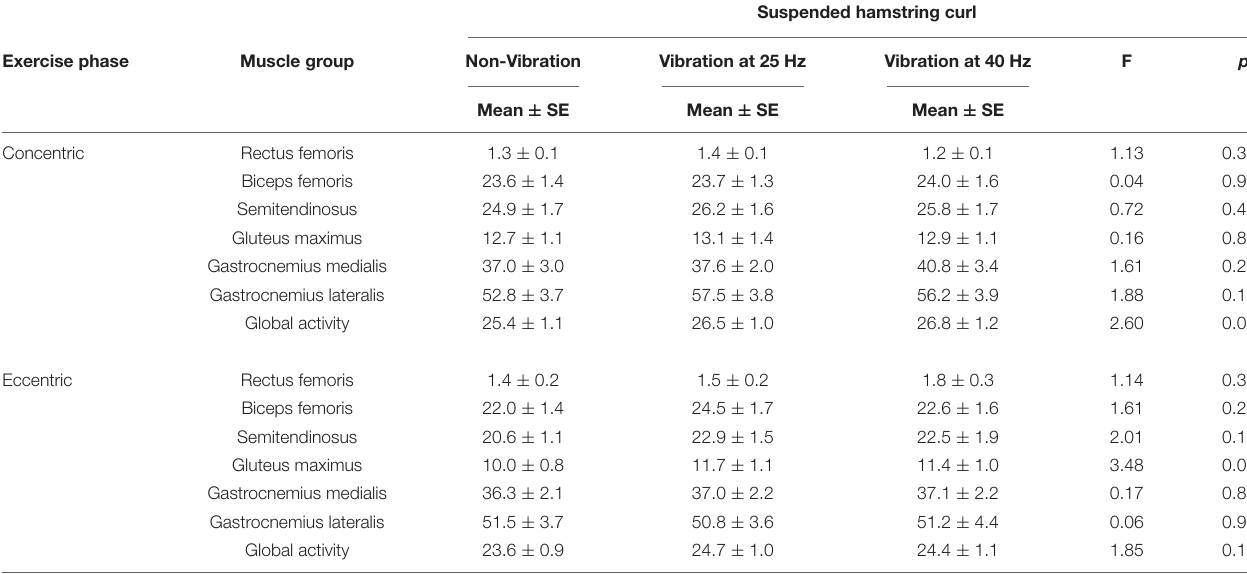
TABLE 2 | The sEMG activity for each analyzed muscle under suspended hamstring curl